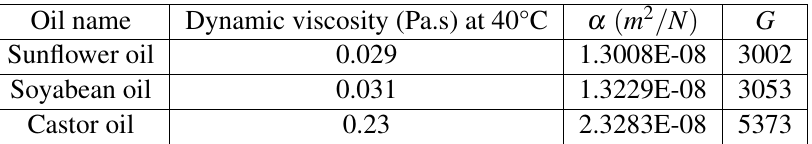
Table 2 Physical properties of tested oil at